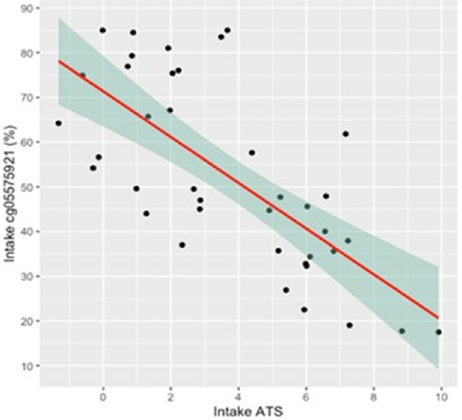
Figure 2. The relationship between intake cg05575921 methylation and ATS score. Intake cg05575921 is highly correlated with intake ATS ( n = 39, p < 0.0001; adjusted R 2 = 0.49). Shaded area represents the 95th percentile confidence zone.